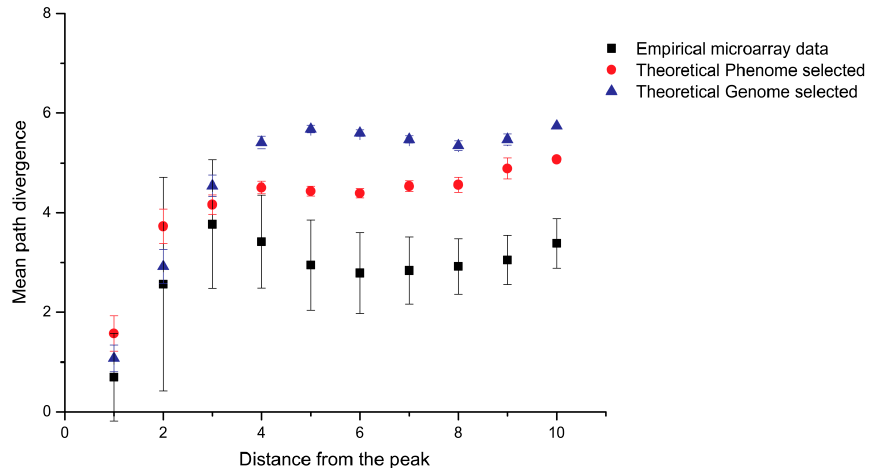
Figure 2. Comparison of novel phenome selected model to both genome selected and empirical aptamer microarray binding data. The mean path divergence analysis, a measure of landscape smoothness, shows that the novel phenome selected landscape is more similar to empirical microarray binding data than the previous genome selected landscape model. Figure adapted from Kinghorn et al.